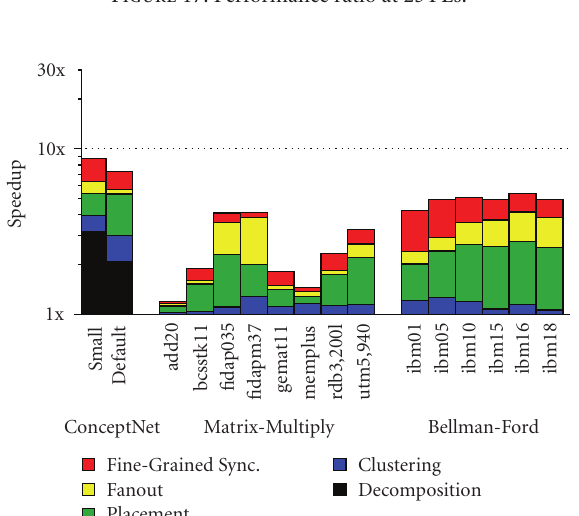
Figure 17: Performance ratio at 25 PEs.